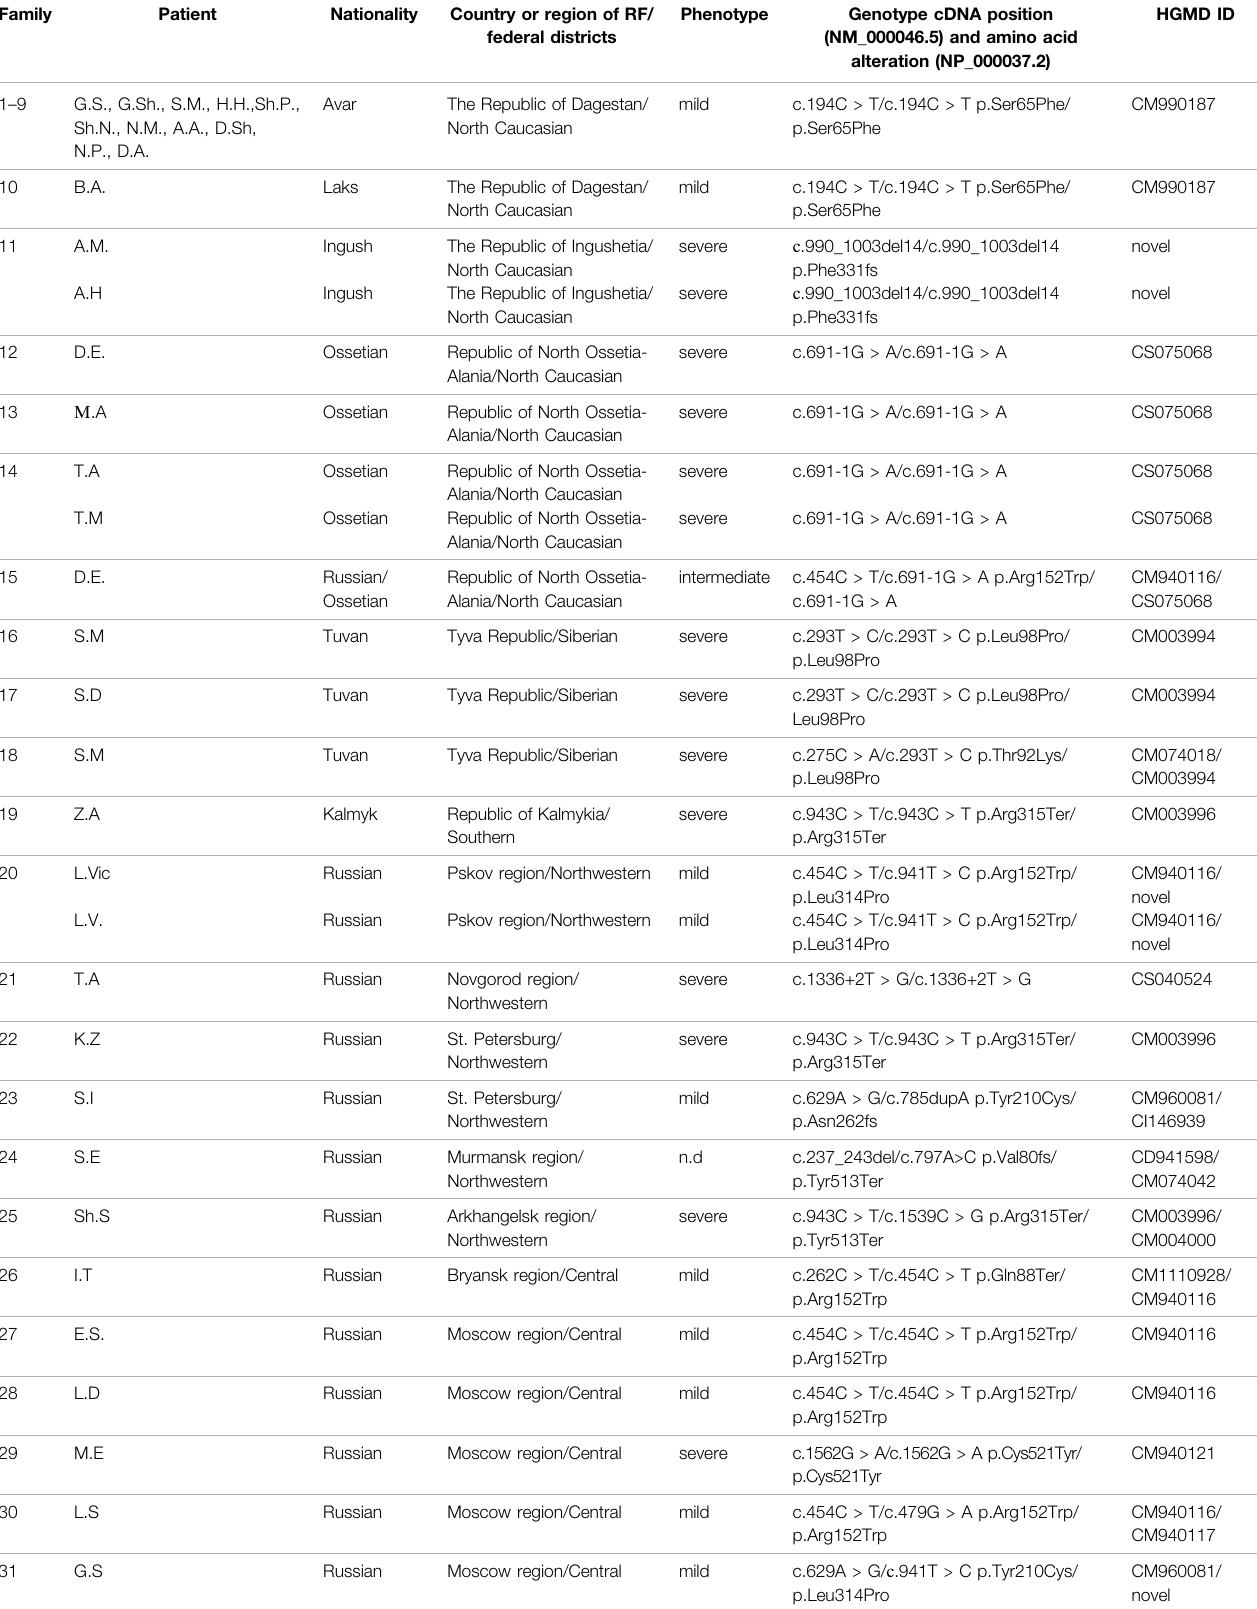
TABLE 1 | Genotype and phenotype of patients with an indication of the place of residence and nationality.